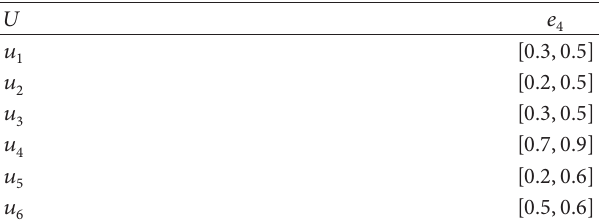
Table 6: Tabular representation of the IVF soft set C